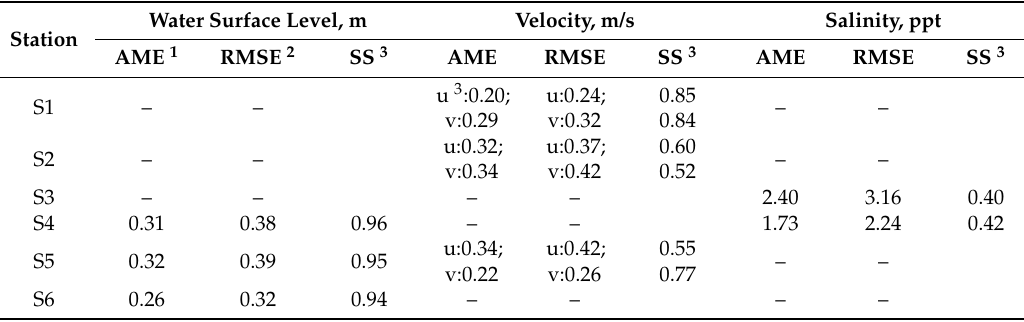
Table 1. Hydrodynamic model calibration error statistics, May